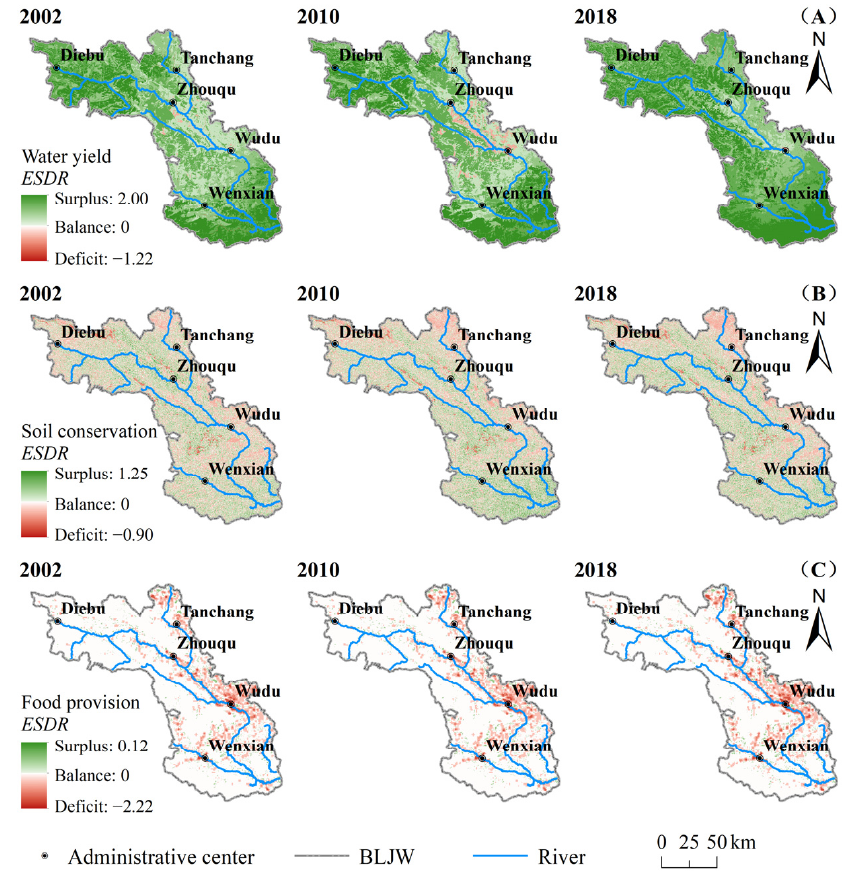
Figure 4. Spatial pattern of the supply–demand ratio of the ESs in the BLJW from 2002 to 2018. Note: series ( A ) shows the ESDR of water yield from 2002 to 2018, series ( B ) shows the ESDR of soil conservation from 2002 to 2018, series ( C ) shows the ESDR of food provision from 2002 to 2018.